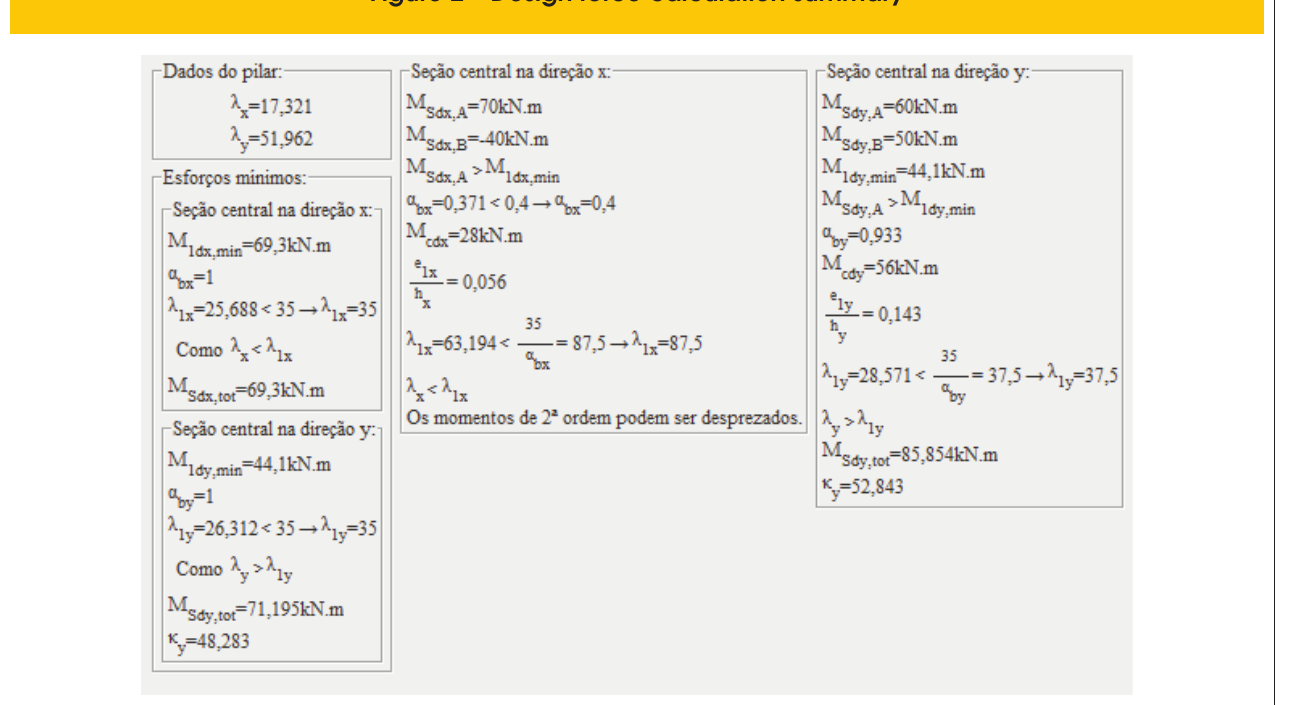
Figure 2 – Design force calculation